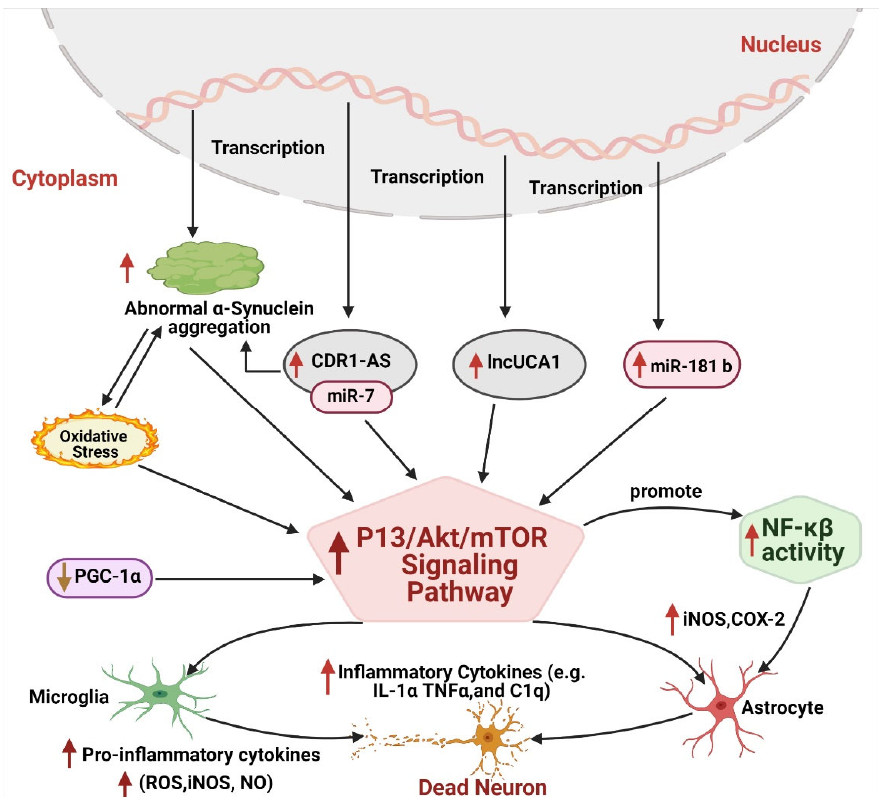
Figure 4. The landscape of synergic epigenetic interactions with P13K/Akt/mTOR signaling pathway in PD development. P13K/Akt/mTOR signaling pathway is activated due to overexpression of lncRNA UCA 1 and miR ‐ 181b, which leads to ROS production and other inflammatory responses. Similarly, CDR1 ‐ AS sponge with miR ‐ 7 and increases mTOR signaling. Moreover, lower expression of PGC ‐ 1 α also regulated the inflammatory phenotype of microglia and enhanced P13K/Akt/mTOR pathway signaling. Activated P13K/Akt/mTOR signaling pathway enhances NF ‐κβ activity that further releases pro ‐ inflammatory cytokines along with iNOS and COX ‐ 2. Altogether, these epigenetic mechanisms interact with each other and with P13K/Akt/mTOR signaling pathways to induce neuroinflammation in PD development. Note *: ↓ shows downregulated expression, and ↑ shows an upregulated expression. Intriguingly, CDR1 ‐ AS, as the most abundant circRNA, has been widely associated with neurological disorders. CDR1 ‐ AS contains more than 70 sites for miR ‐ 7 and sponge effectively with miR ‐ 7. It is normally involved in the storage and transportation of miR ‐ 7. A body of evidence has shown that the CDR1 ‐ AS ‐ miR ‐ 70 axis plays a significant role in